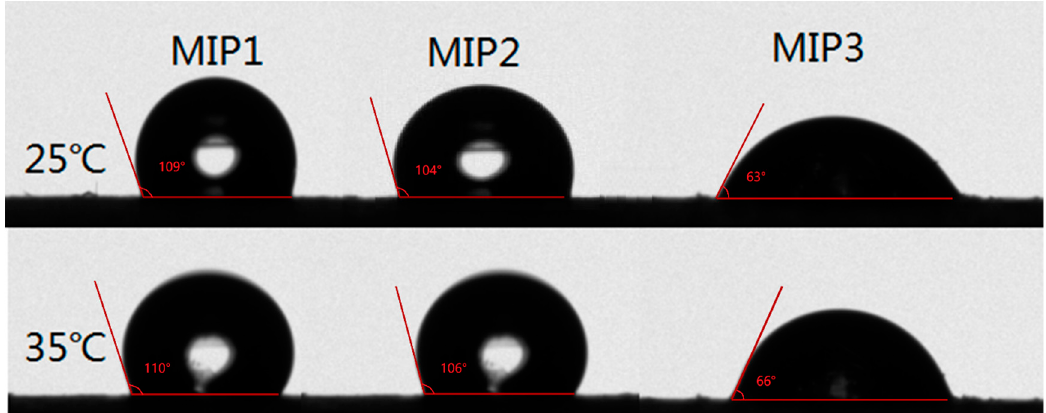
Figure 3. The test of static water contact angles of the different MIPs at 25 °C and 35 °C, respectively.